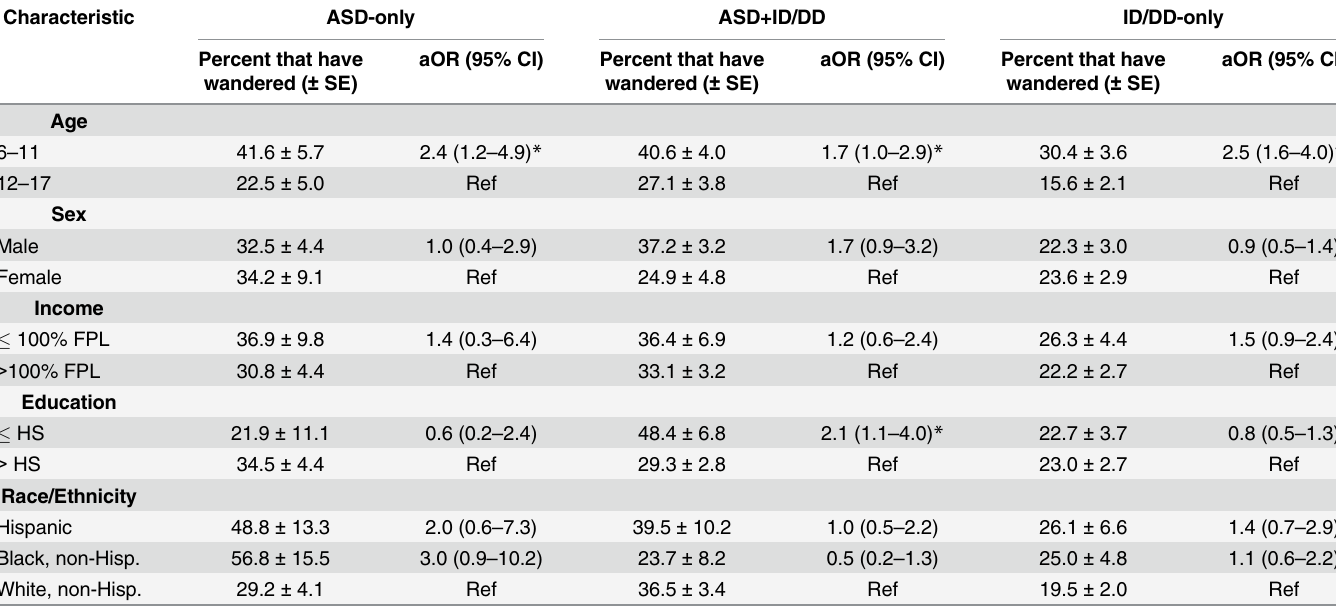
Table 4. Demographic Characteristics Associated with Elopement.